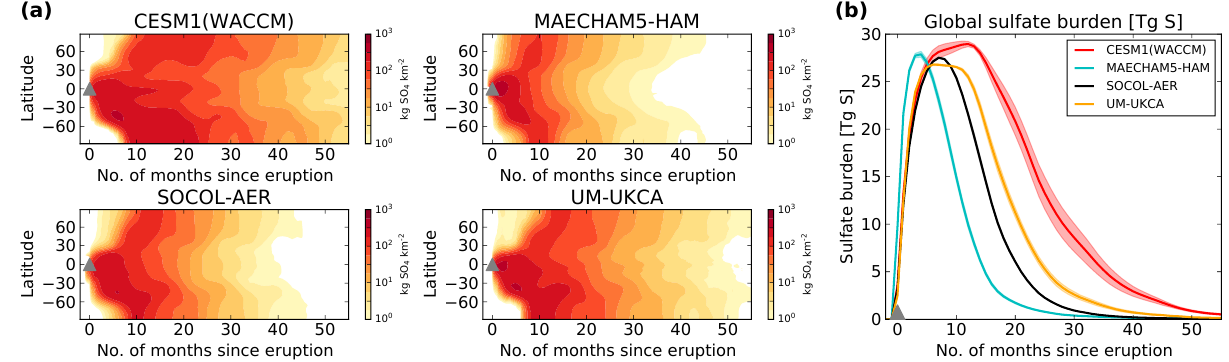
Figure 10. (a) Zonal mean atmospheric sulfate burdens in each model (kgSO 4 km − 2 ) (ensemble mean) and (b) global atmospheric sulfate burdens (TgS) in each model (colours). Ensemble means are shown by the coloured lines; shadings mark 1 SD. Sulfate burdens are monthly mean anomalies. The grey triangles mark the start of the eruption (1 April